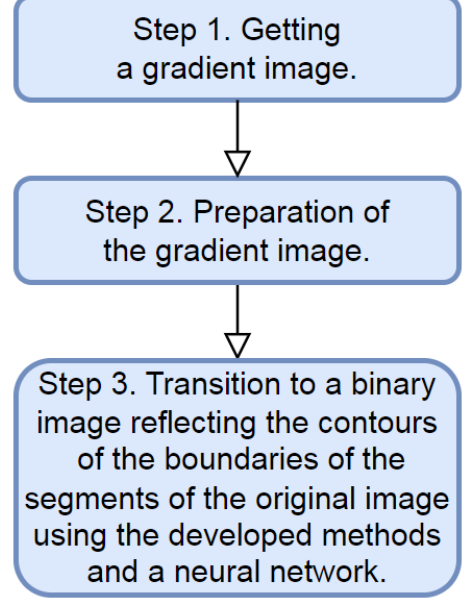
Figure 20. The suggested segmentation